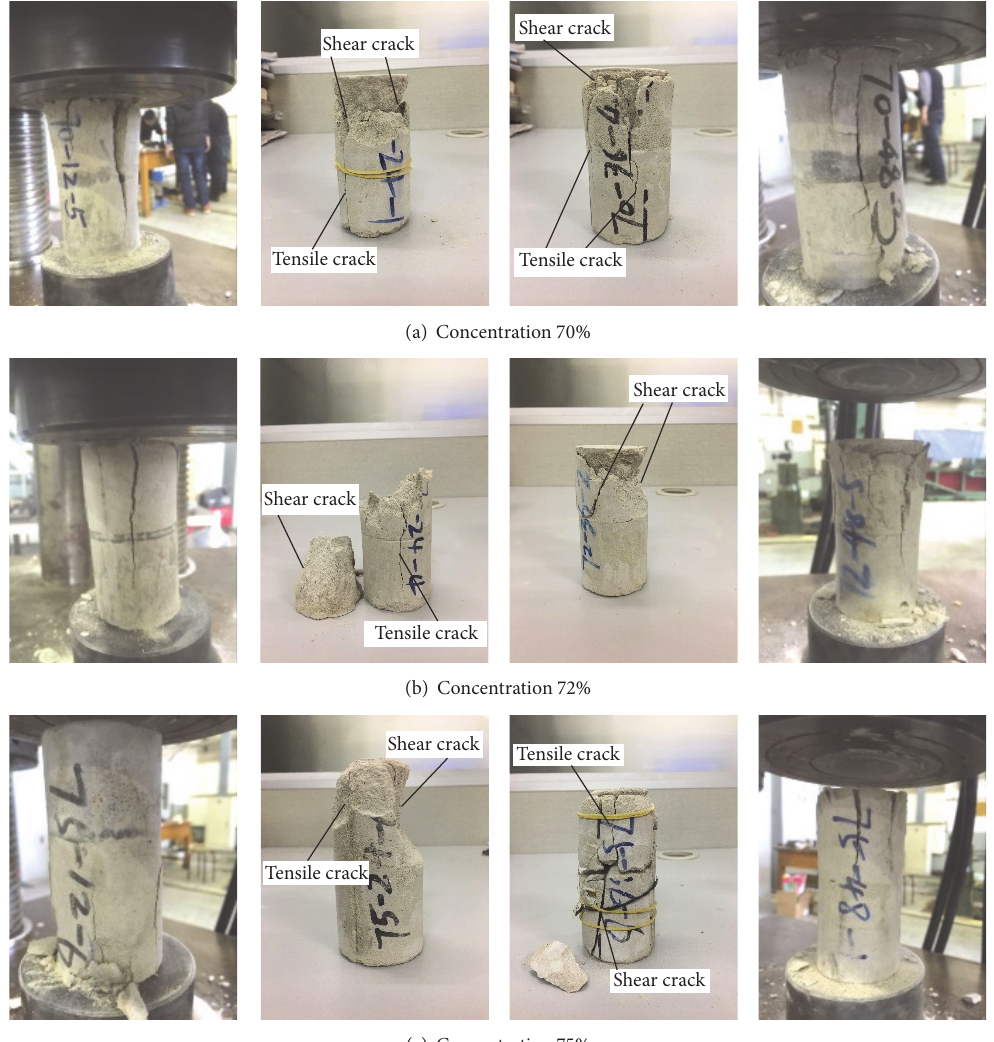
Figure 8: The failure modes of cemented backfill samples under different